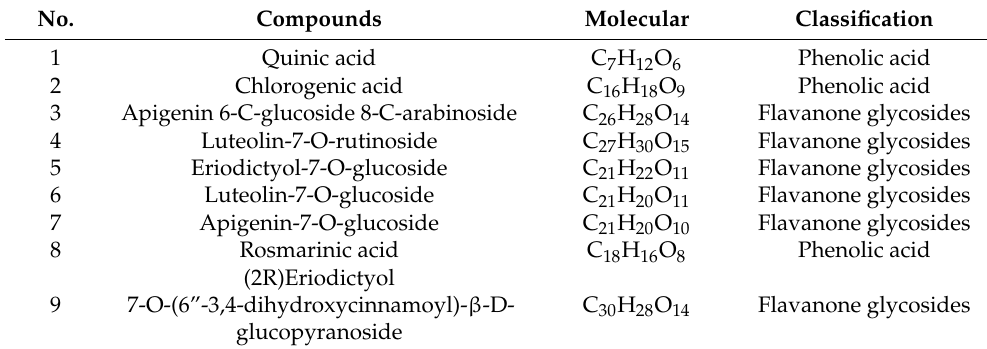
Table 1. Main chemical components of EBE. The information of the EBE compounds identified by the